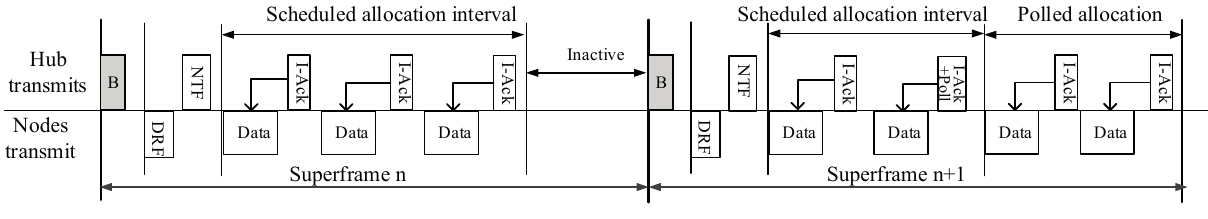
Figure 10. Frame transactions in scheduled and polled allocation